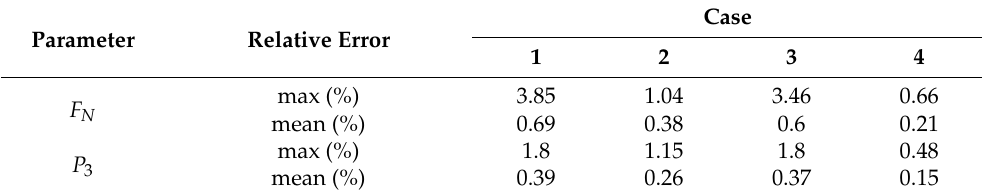
Figure 12. Relative errors of the parameter P 3 . Table 6. Relative errors (absolute value) of parameters F N and P 3